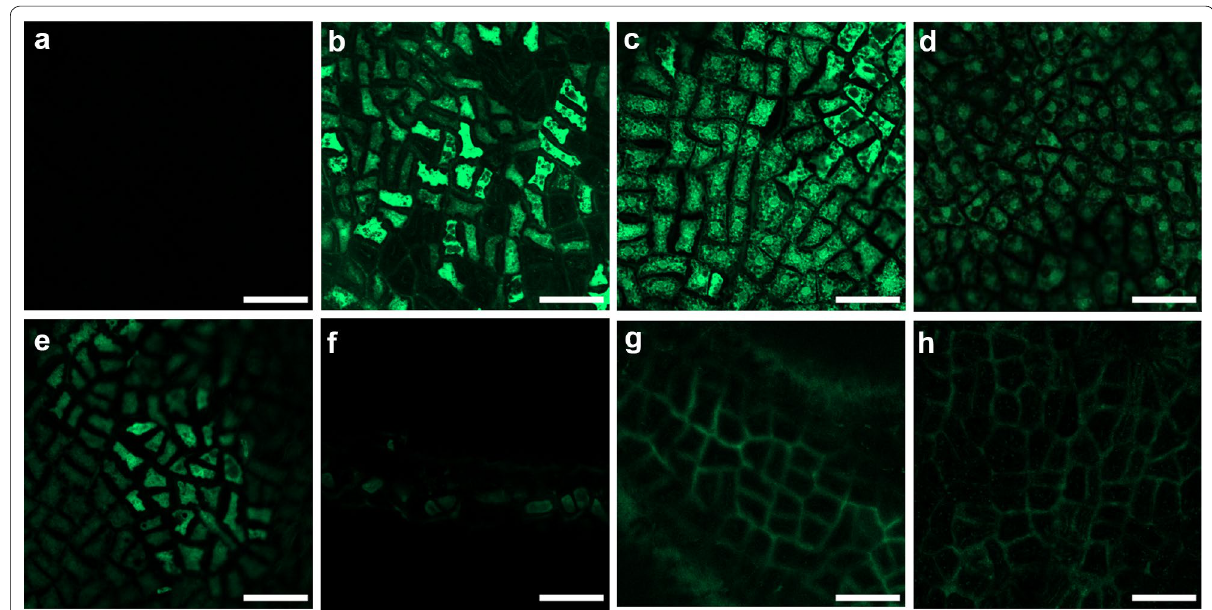
Fig. 4 Cell‑to‑cell movement of fluorescent symplastic tracer in soybean endosperm. Isolated soybean endosperm from 35 DAF seeds loaded with a 1/2 MS media, b HPTS; c 10‑kDa, d 20‑kDa, e 40‑kDa, or f 70‑kDa F FITC‑dextran; or g 10‑kDa or h 70‑kDa FITC‑dextran with DCCD. Scale bars 50 =